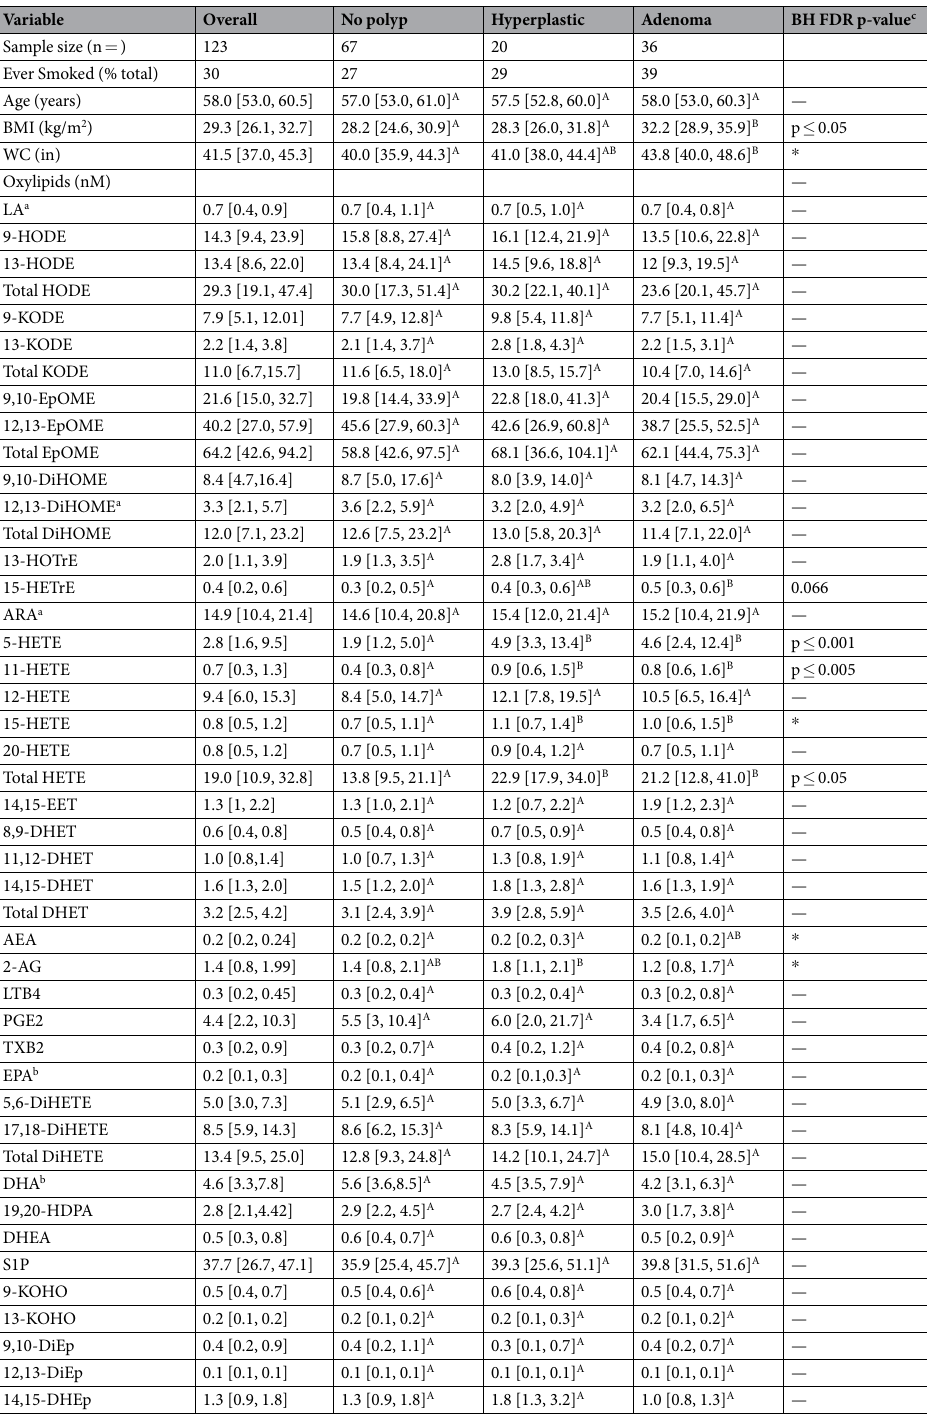
— Table 1. Presence of polyps is associated with increased plasma concentrations of monohydroxy arachidonic acid-derived oxylipids (values expressed as median [Q1, Q3]). Oxylipid totals were calculated as follows: Total HODE calculated as ∑ 9-HODE + 13-HODE; Total KODE calculated as ∑ 9-KODE + 13-KODE; Total EpOME calculated as ∑ 9,10-EpOME + 12,13-EpOME; Total DiHOME calculated as ∑ 9,10-DiHOME 12,13-DiHOME; Total HETE calculated as ∑ 5-HETE + 11-HETE + 12-HETE + 15-HETE + 20-HETE; Total DHET calculated as ∑ 8,9-DHET + 11,12-DHET + 14,15-DHET; Total DiHETE calculated as ∑ 5,6-DiHETE + 17,18-DiHETE. a Plasma non-esterified LA, 12,13-DiHOME, and AA values are presented as levels (i.e., peak area of compound/ peak area of internal standard), since a majority of participant’s concentrations were greater (i.e., > 10 fold) than the highest standard curve value. b Plasma non-esterified EPA and DHA are expressed as μ M. c Categorical analysis of polyp severity by Kruskal Wallis one-way ANOVA and Dunn’s test for multiple comparison. P-values were corrected for false discovery rate (FDR) according to Benjamini-Hochberg